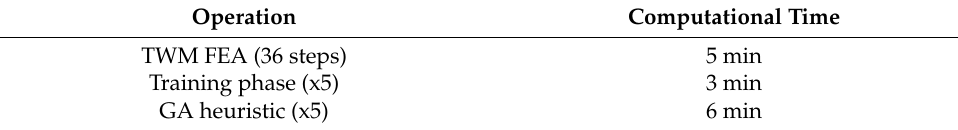
Table 4. Computational times of the heuristic procedure on a Workstation Hp Z440.